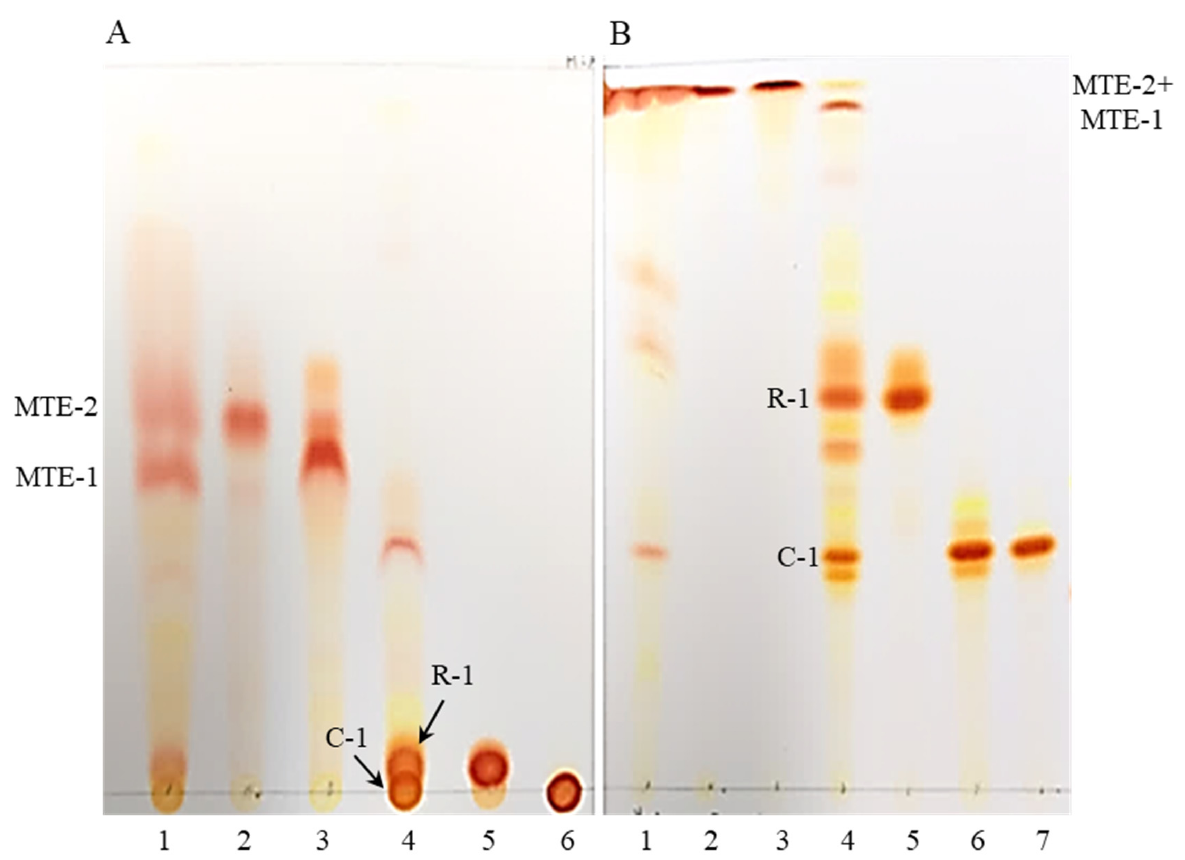
Figure 1. TLC profiles of total extract, MTE-1 and MTE-2 fractions isolated from solvent extract by open column chromatography. 1, un-saponified extract; 2, un-saponified MTE-2 fraction; 3, un-saponified MTE-1 fraction; 4, saponified extract; 5, saponified MTE-2 fraction; 6, saponified MTE-1 fraction; 7, capsanthin (authentic standard). TLC solvents; ( A ), n -hexane: acetone (95:5, v / v ); ( B ), n -hexane: acetone (70:30, v / v ).